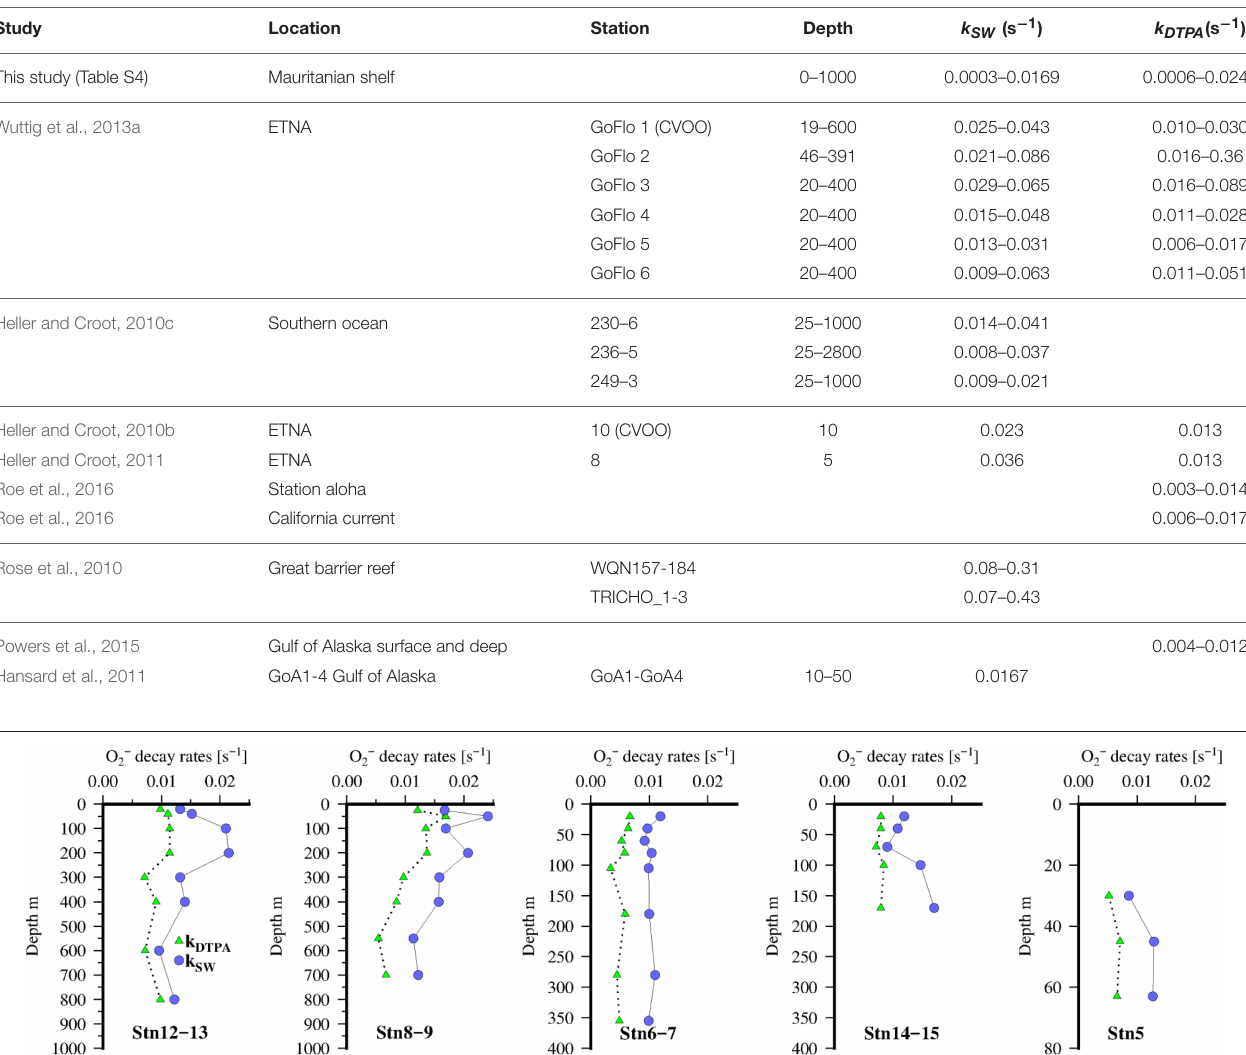
TABLE 2 | Compilation of rates (with and without DTPA) for the decay of O − 2 in seawater during this work and from other studies.